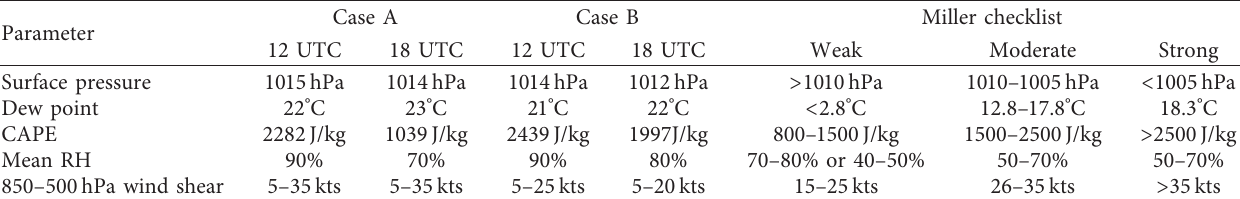
Table 2: Miller checklist of some selected parameters for severe weather adopted from Tajbakhsh et al. [43]. Parameter